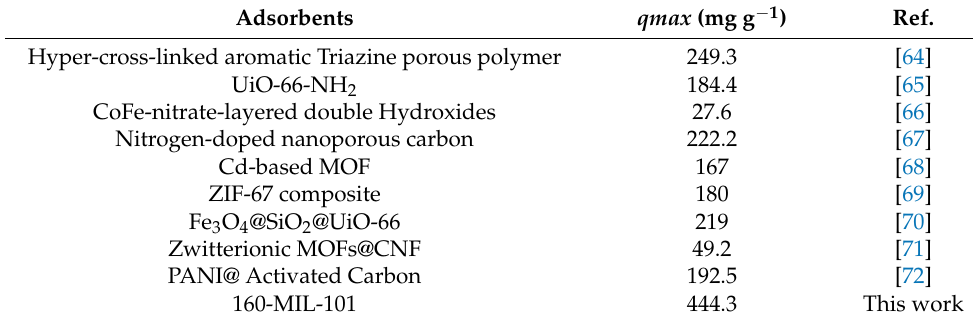
Table 2. Adsorption capacities ( qmax ) of MO on several adsorbents.